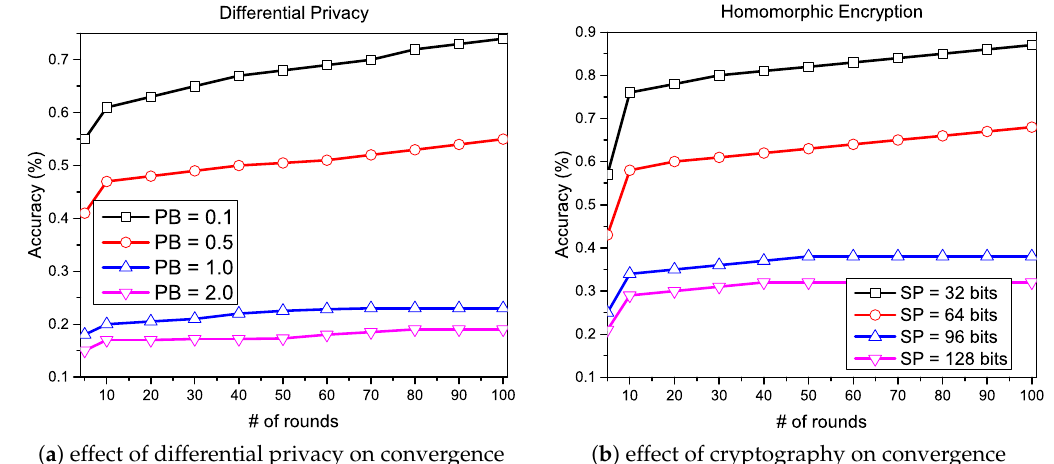
Figure 7. Effect on convergence with the increasing value of privacy and